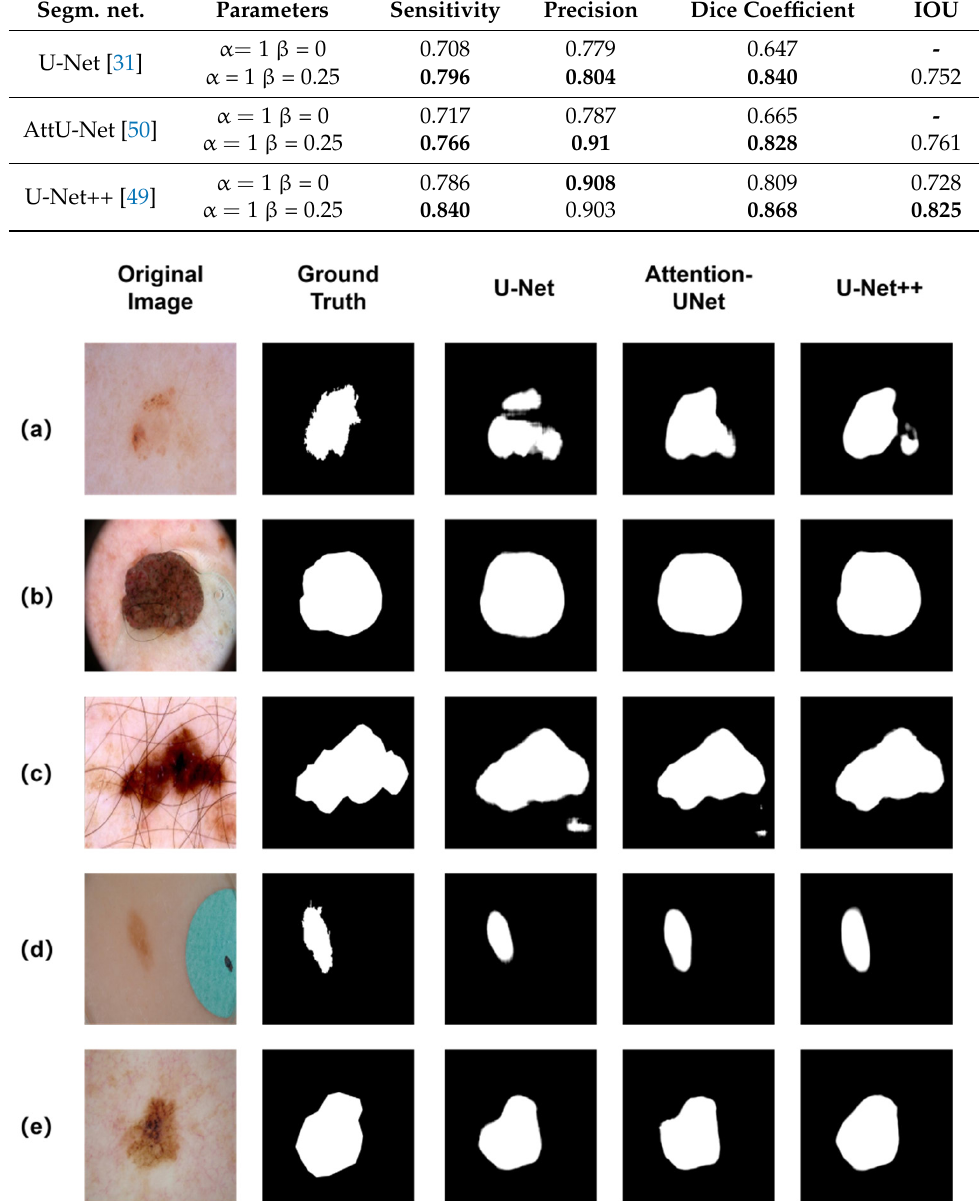
Table 1. Performance analysis and comparison of Our method with the baseline on ISIC 2018 dataset. Segm. net.